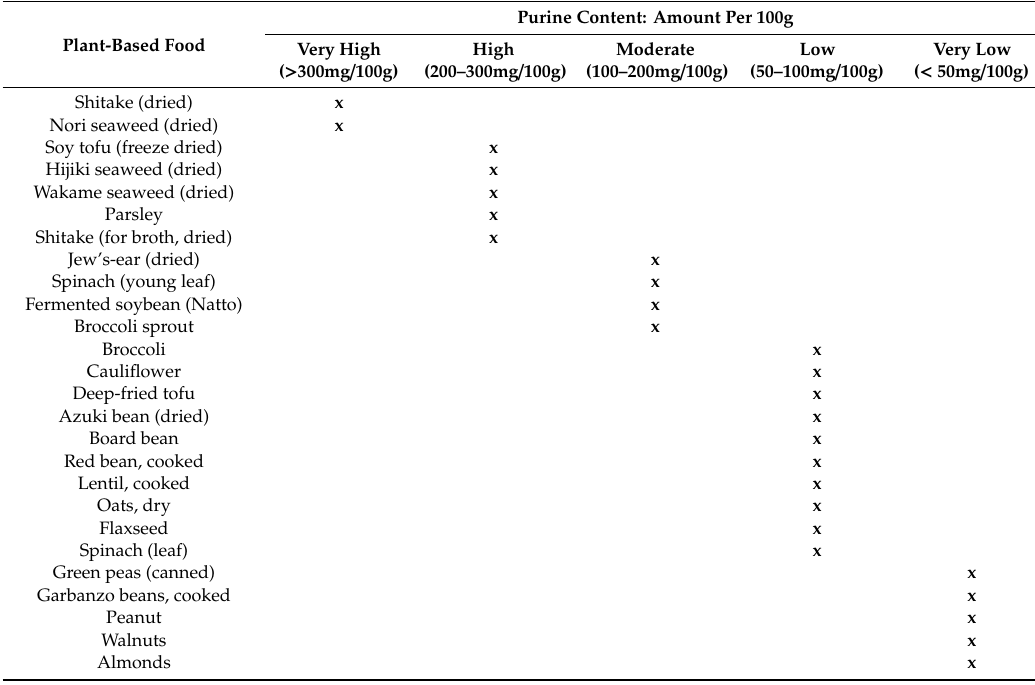
Legend: x, denotes the categorization of food under the respective appropriate purine